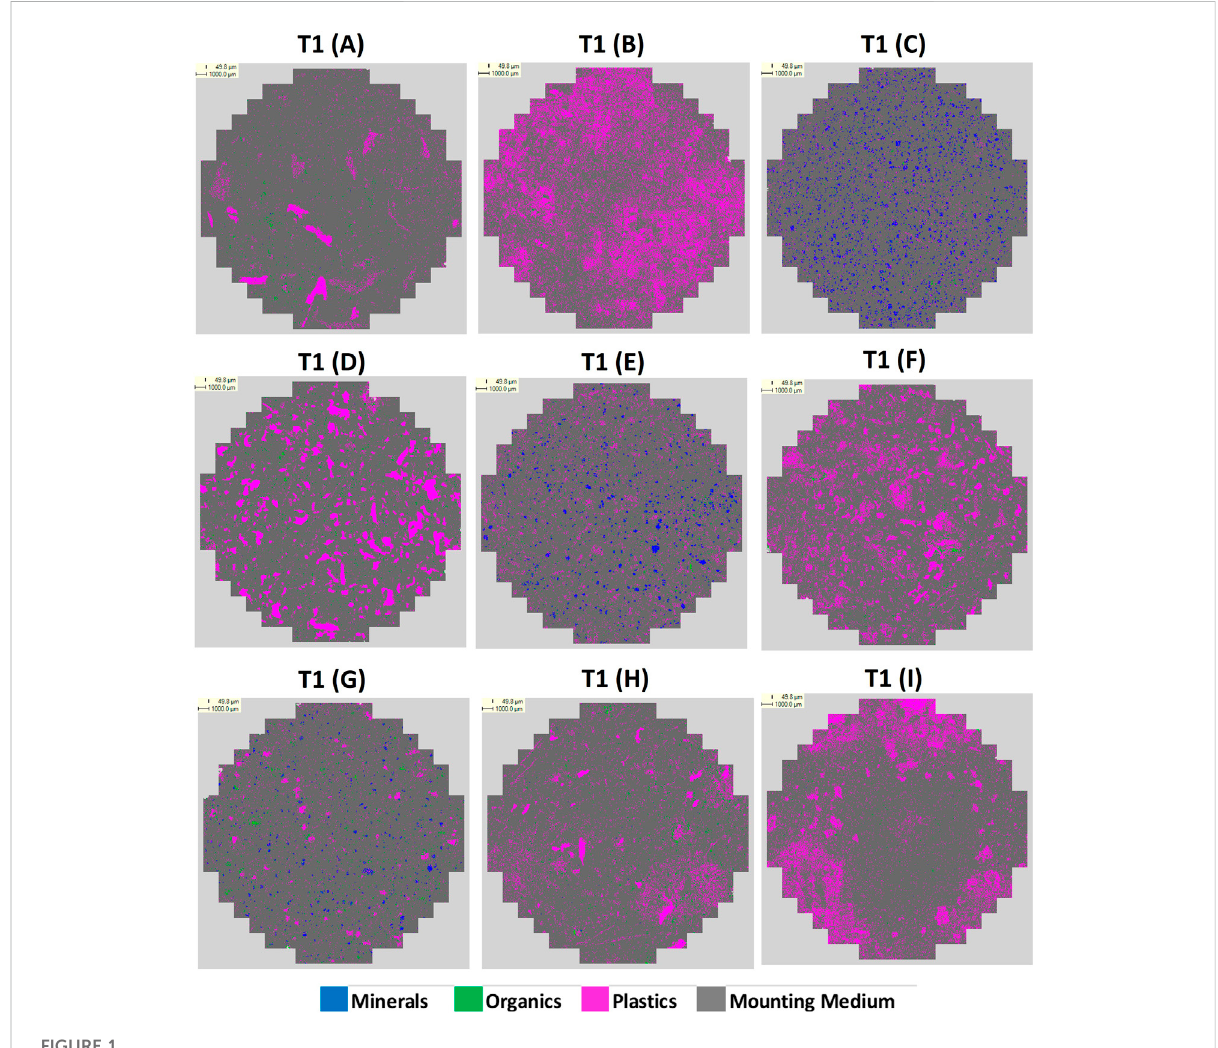
FIGURE 1 Particle map images for T1, samples A –